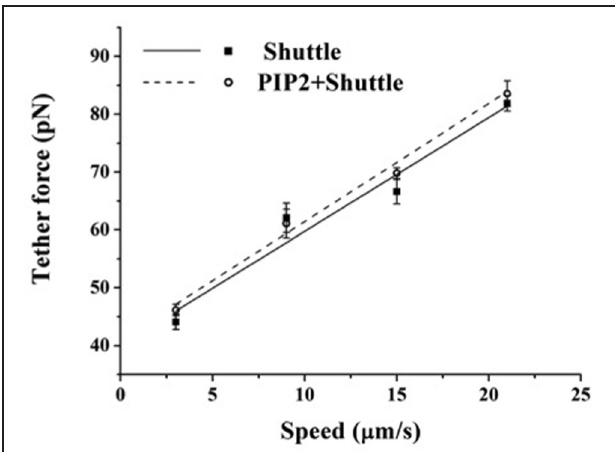
FIGURE 3 | Effect of exogenous PIP2 on the tether force. Tether force vs. pulling speed in BAEC treated with PIP2-Shuttle. Cells treated with the Shuttle alone were used as control. The two curves are statistically indistinguishable ( p > 0 . 05). (The slope of the curves, 2 πη eff , is 1.97 pN · s/ μ m and 2.04 pN · s/ μ m, respectively, for the cells treated with Shuttle alone and cells loaded with exogenous PIP2 + Shuttle). Error bars represent SEM.